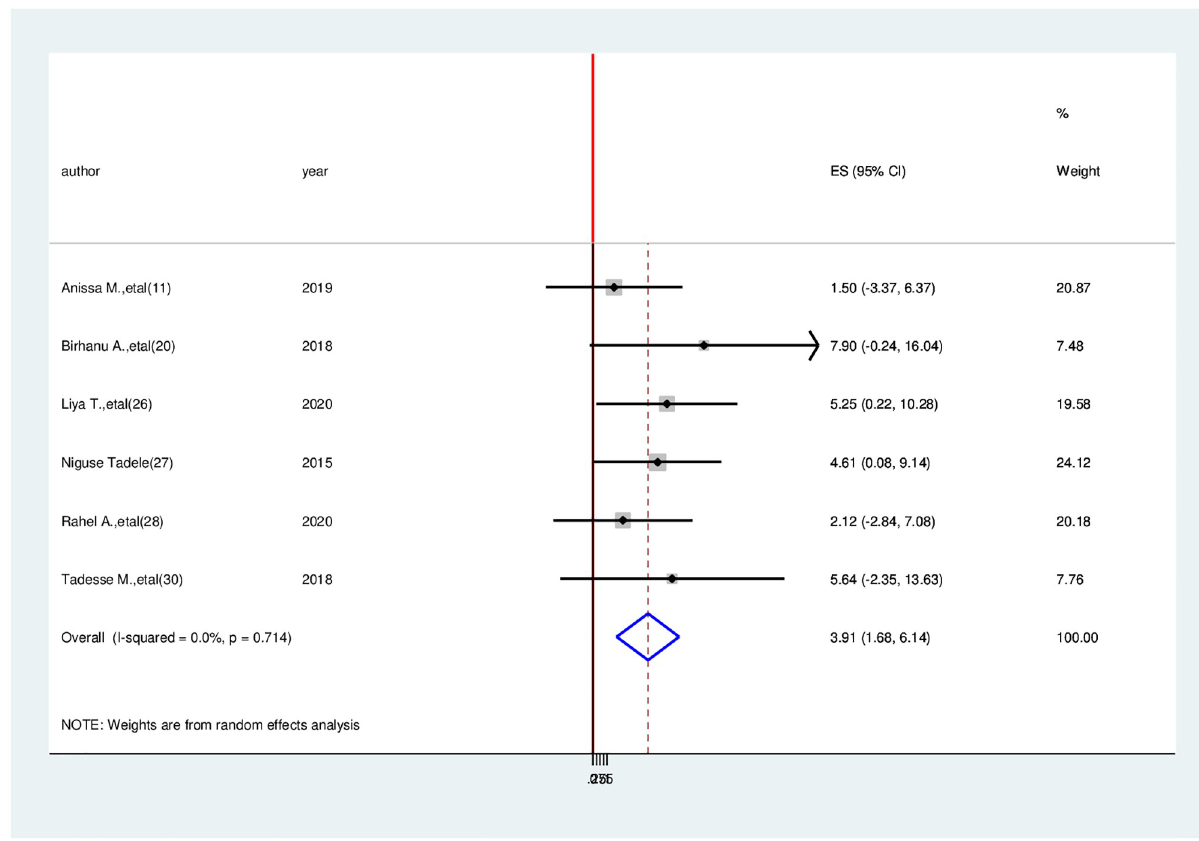
Fig 8. Association between having social functioning and health-related quality of life among cancer patients in